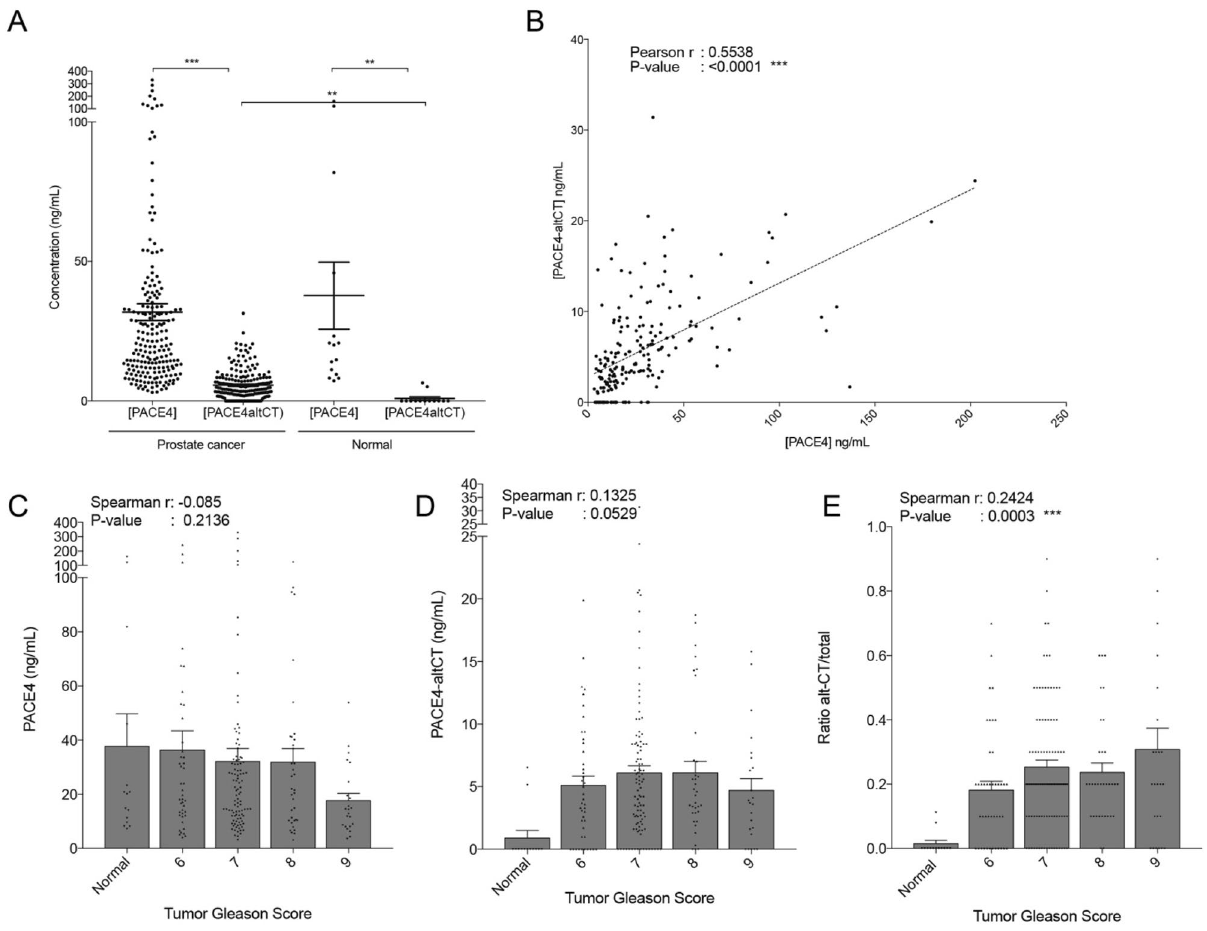
Figure 5. PACE4 and PACE4-altCT plasmatic concentration in PCa patients. ( A ) ELISA-determined concentration of total PACE4 and PACE4-altCT in plasma from PCa patients (n = 205) and normal patients (n = 13). Each individual data is shown as a dot, bars represent mean with SEM. ( B ) Correlation analysis between the concentration of PACE4 and PACE4-altCT for each PCa patient. The dashed line represents the linear regression. ( C ) Concentrations and correlation analyzes of total PACE4, ( D ) PACE4-altCT concentrations and ( E ) PACE4-altCT/total PACE4 ratios in the plasma of normal and PCa patients according to their respective tumor Gleason score. All data points are shown as a dots, normal n = 13, Gleason 6 (n = 43), Gleason 7 (n = 100), Gleason 8 (n = 33), Gleason 9 (n = 9). Bars are means ±